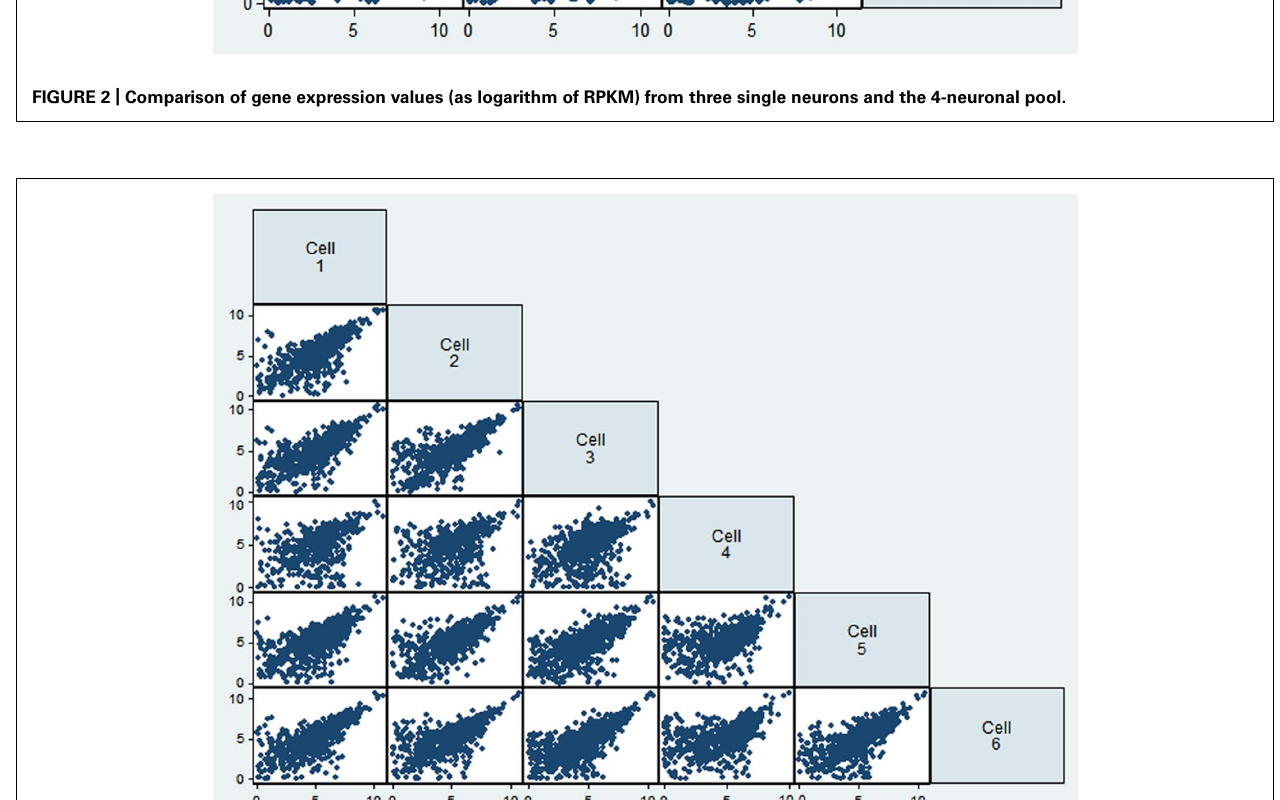
FIGURE 3 | Comparison of gene expression values (as logarithm of RPKM) for six single neuronal cells from cell culture.